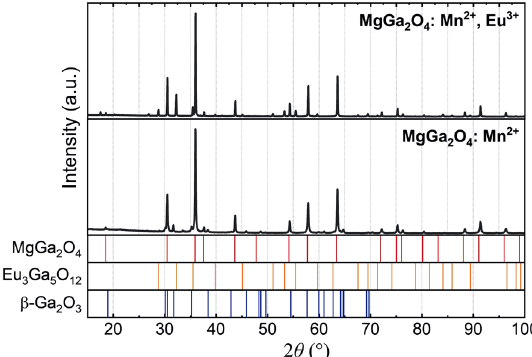
Fig. 1 Experimental XRD patterns of MgGa 2 O 4 :Mn 2+ and MgGa 2 O 4 :Mn 2+ ,Eu 3+ ceramics (the theoretical Bragg reflections of corresponding phases are shown for com- parison at the bottom).